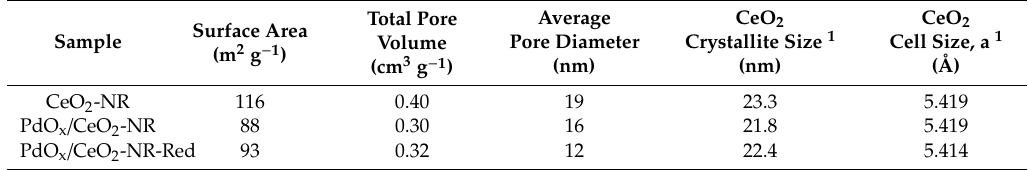
Figure 1. X-ray di ff raction (XRD) patterns of the samples: ( a ) ceria nanorods (CeO 2 -NR), ( b ) Figure 1. X-ray diffraction (XRD) patterns of the samples: ( a ) ceria nanorods (CeO 2 -NR), ( b ) PdO x / CeO 2 -NR, and ( c ) reduced PdO x / CeO 2 -NR (PdO x / CeO 2 -NR-Red). PdO x /CeO 2 -NR, and ( c ) reduced PdO x /CeO 2 -NR (PdO x /CeO 2 -NR-Red). Table 1. Textural properties and CeO 2 cell size of the Table 1. Textural properties and CeO 2 cell size of the samples.